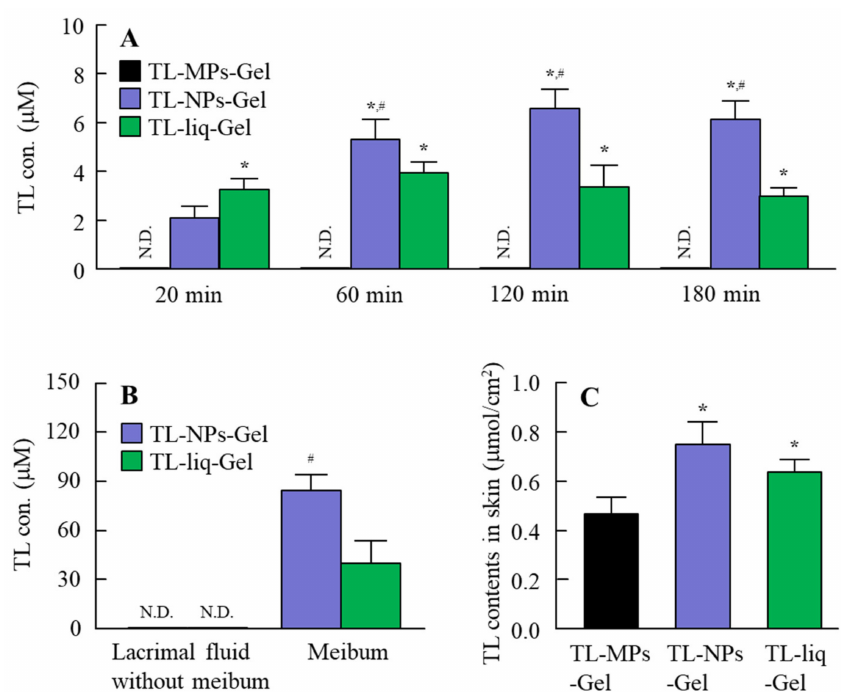
Figure 5. TL concentrations in the lacrimal fluid and meibum of rabbits treated with TL formulations. ( A ) TL concentration in the lacrimal fluid after treatment with TL formulations. ( B ) TL concentrations in the meibum and lacrimal fluid without meibum 180 min after treatment with TL formulations. ( C )